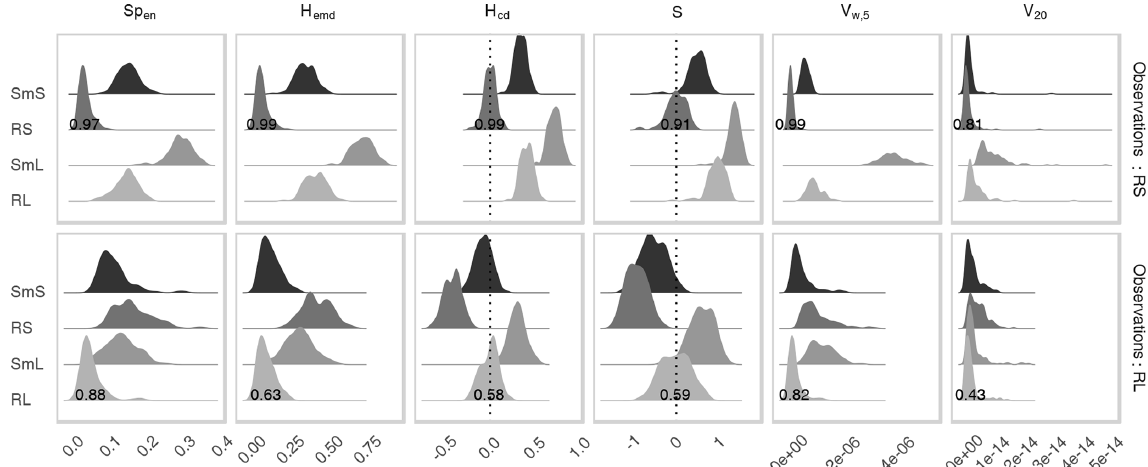
Figure 5. Distribution of all probabilistic scores for each of the forecast ensembles corresponding to the four models from Table 2. Top row: observations drawn from RS. Bottom row: observations drawn from RL. Numbers denote the fraction of cases in which the forecast from the correct distribution received the best score.